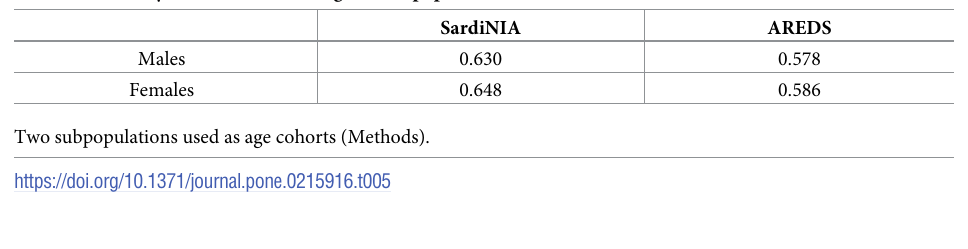
Table 5. Accuracy of classification of age in two populations.